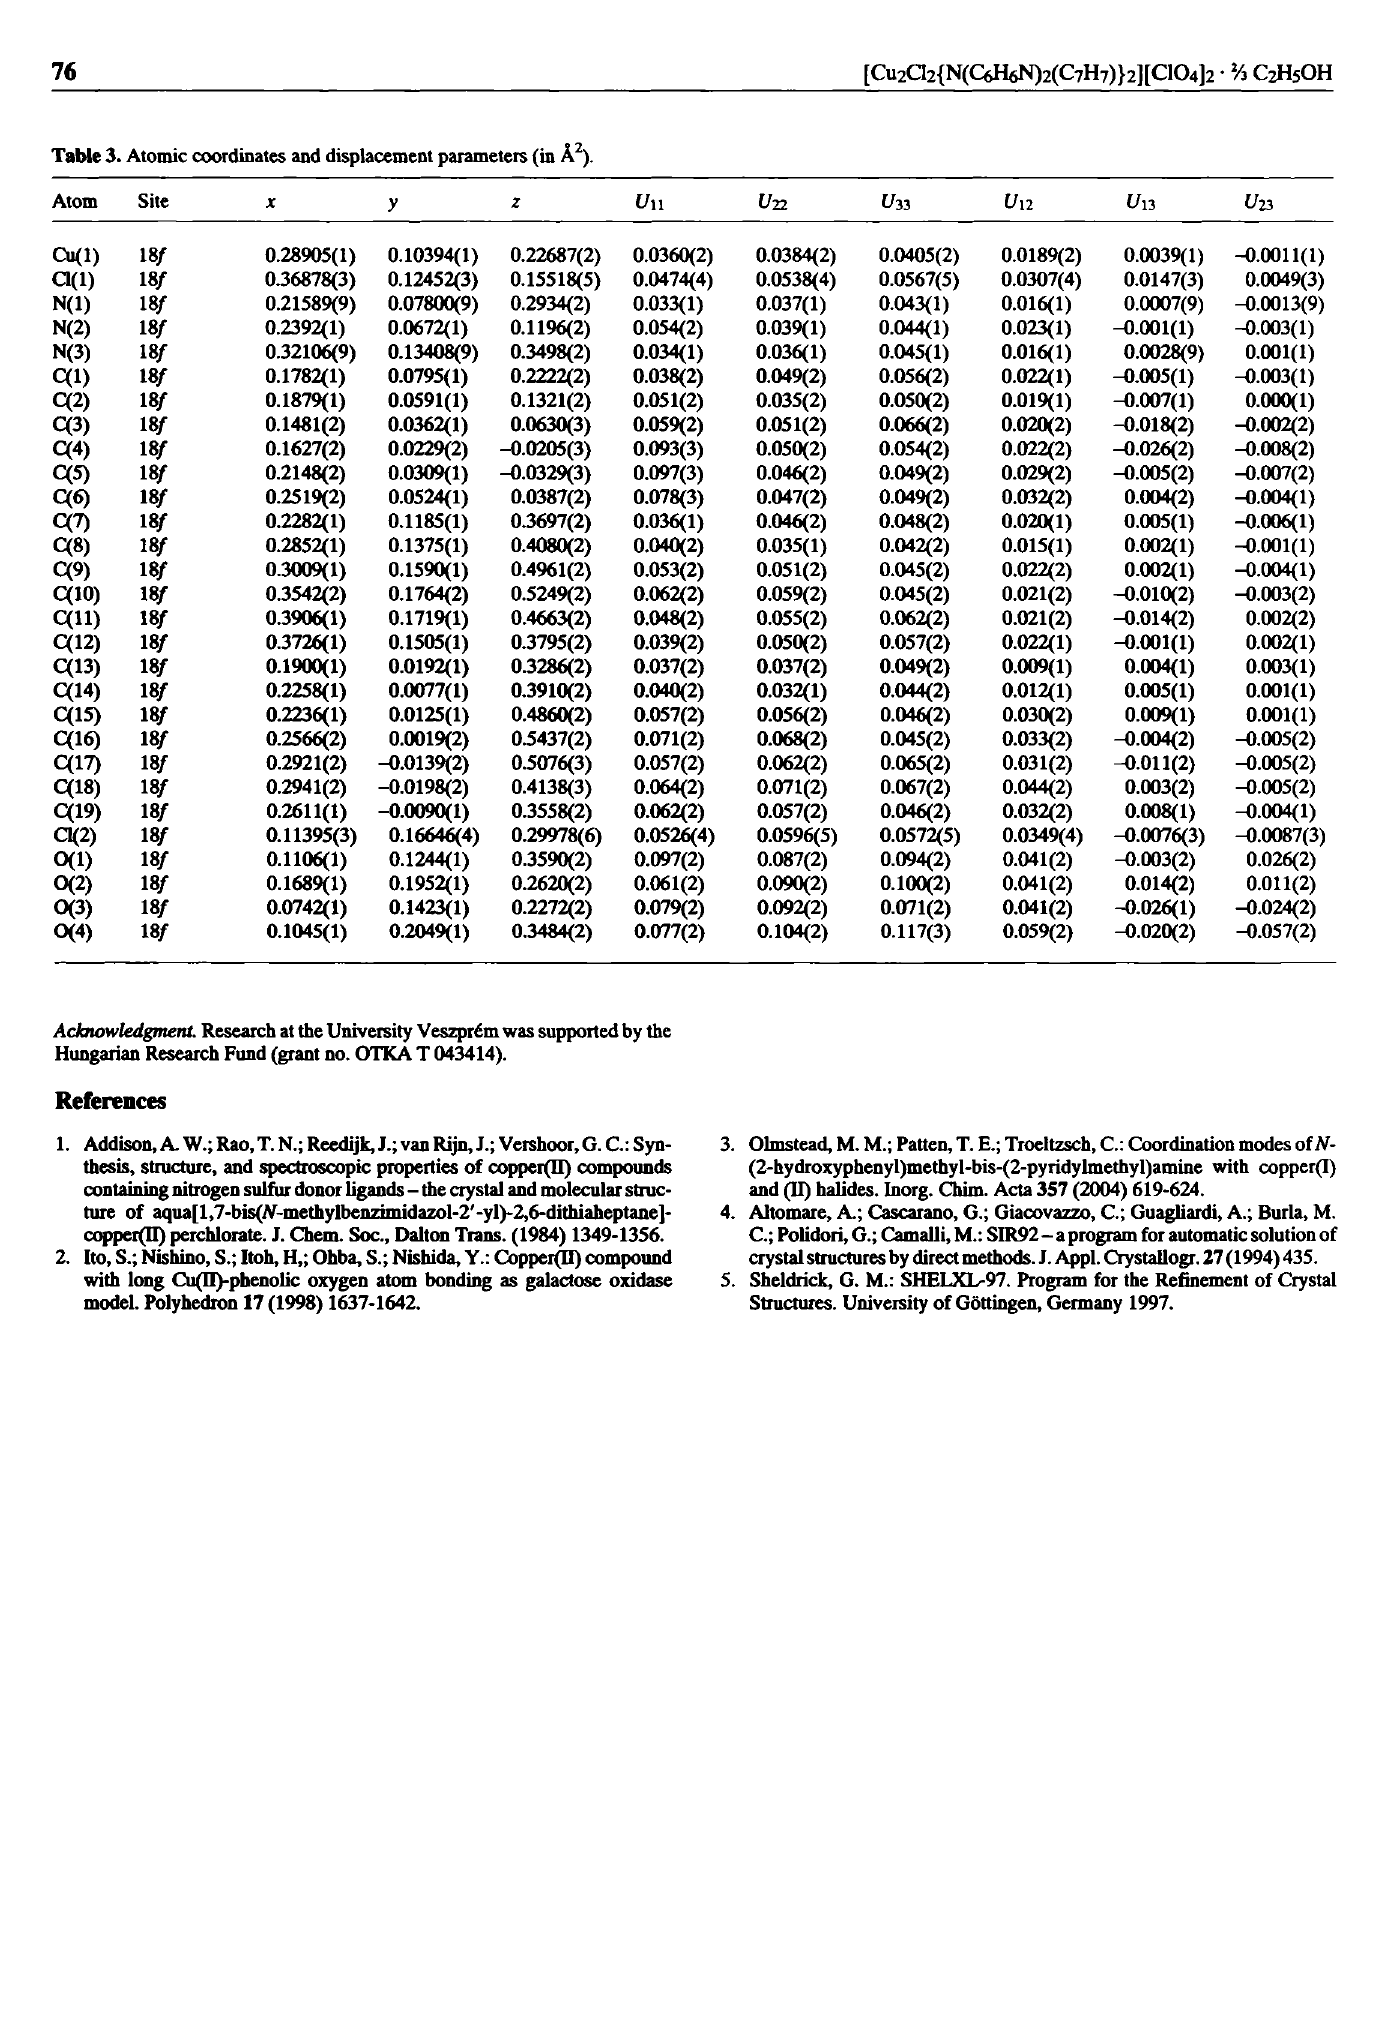
Table 3. Atomic coordinates and displacement parameters (in A 2